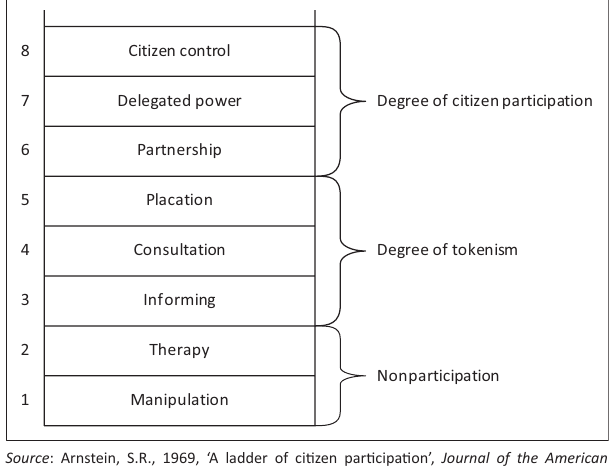
FIGURE 1: Arnstein’s ladder of citizen